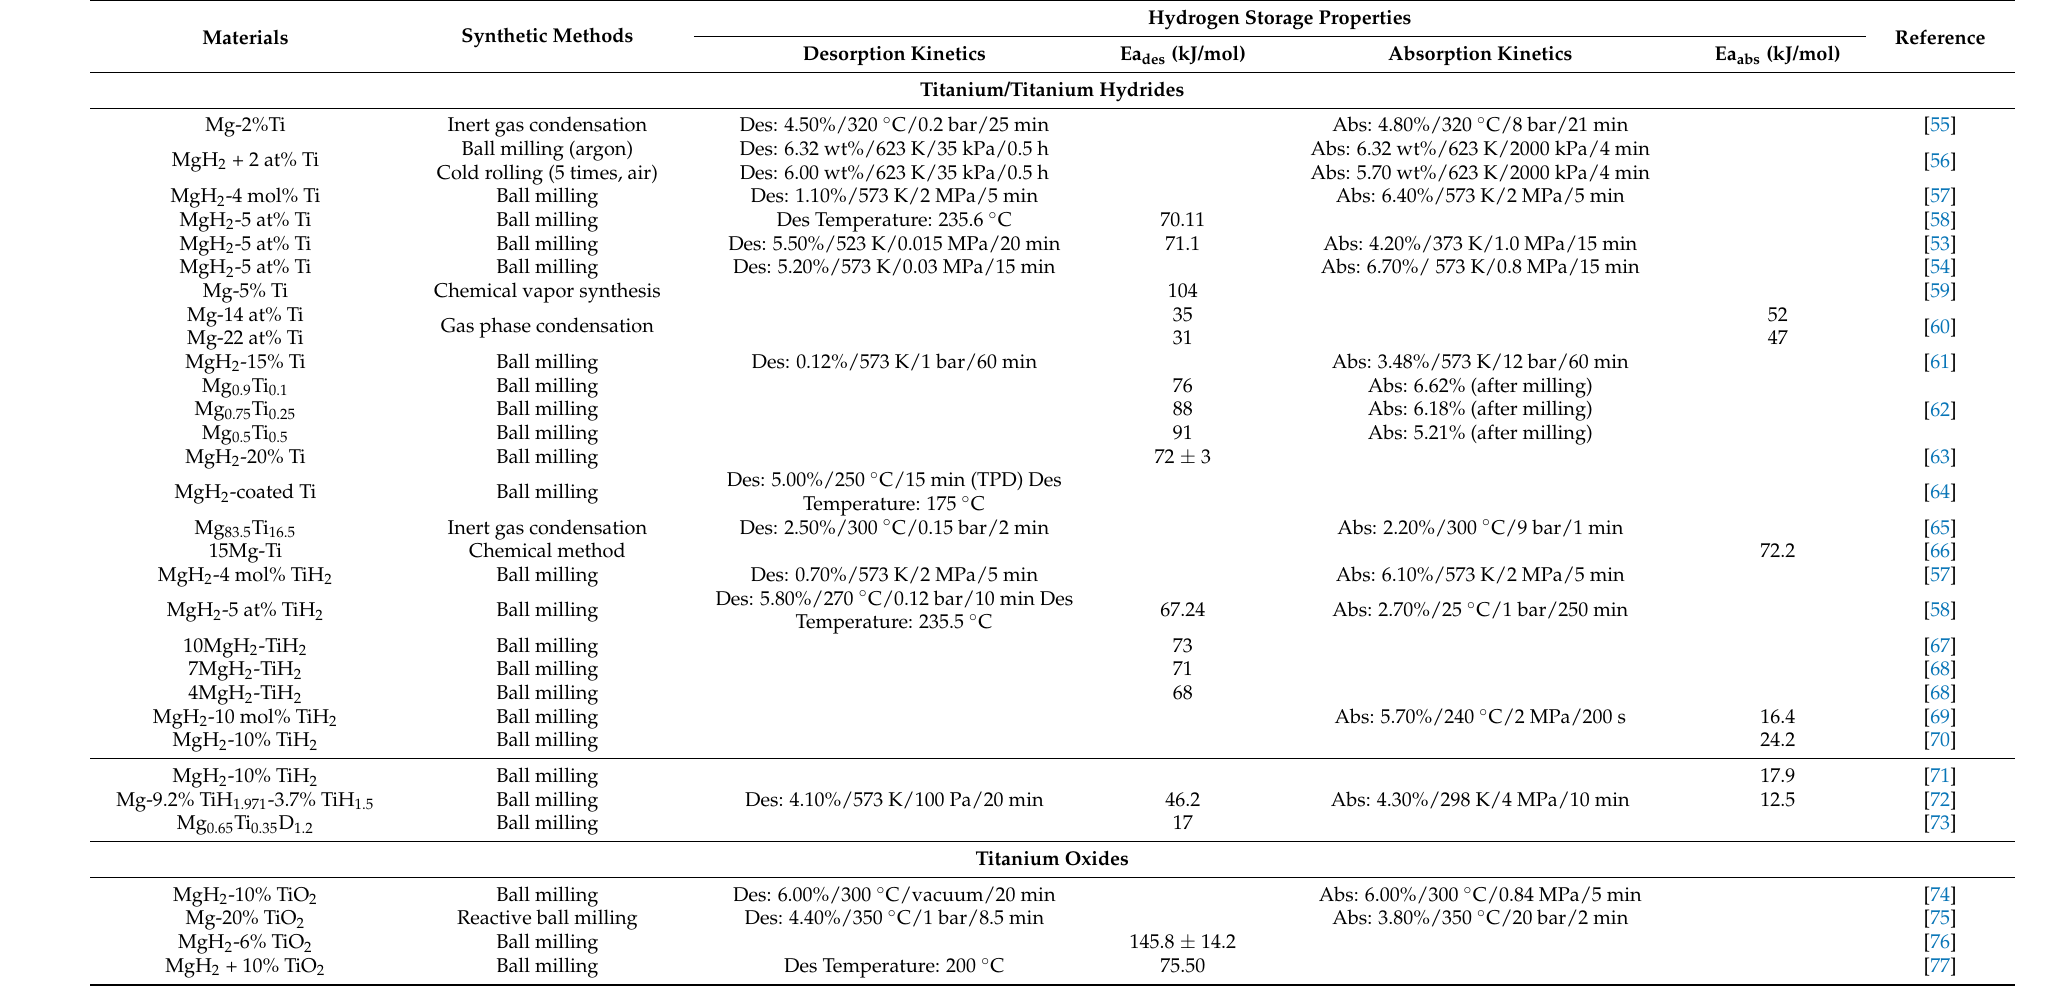
Table 4. Hydrogen storage properties of Mg with various types of Ti-based